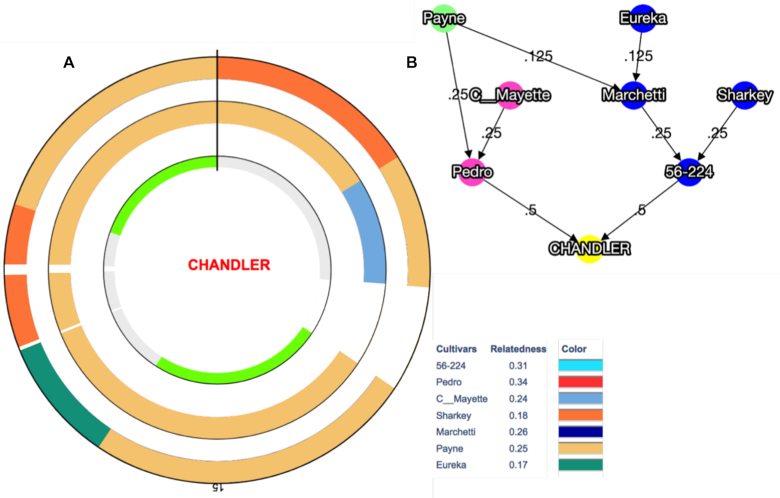
Graphical visualization of haplotype block (HB) inheritance on Chr15 along with the Chandler pedigree. (A) The inner circle highlights in grey 2 regions of heterozygosity (5 HB the first and 7 HB the second), and in light green 2 regions of homozygosity (3 HB the first and 4 HB the second). The circle in the middle shows maternally inherited HBs, while the HBs inherited through the paternal line are visualized in the outer circle. Payne's haplotypes are clearly present in both parental lines. White spaces represent segments of missing haplotype information. (B) Chandler pedigree, where Pedro is the maternal line and 56–224, the paternal line.